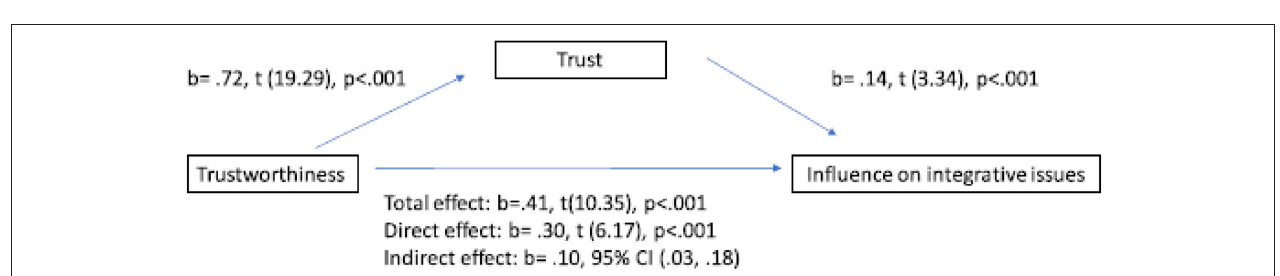
FIGURE 1 | Total effect vs. direct effect vs. indirect effect on influence on distributive issues.